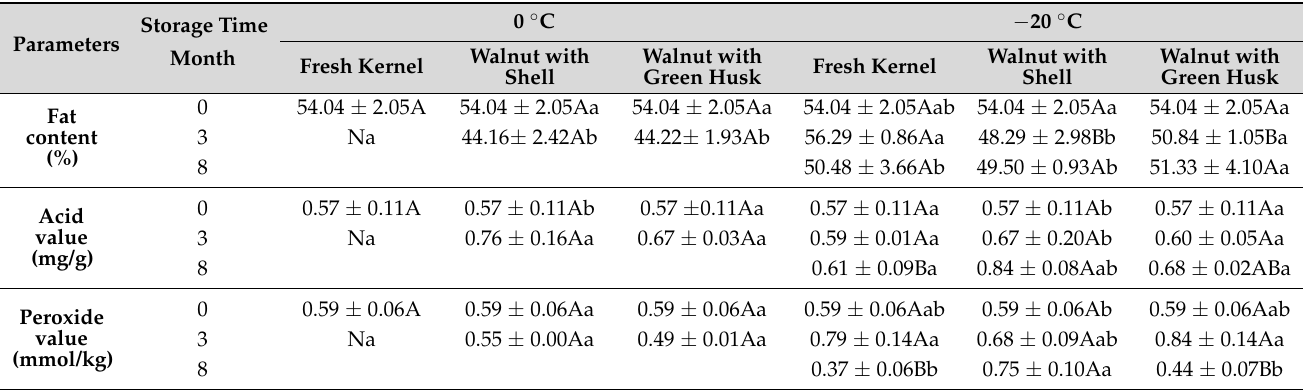
Table 3. Total fat content, acid value and peroxide value of walnut kernels during the storage at 0 ◦ C and − 20 ◦ C. Note: Na means not available. Values with different lowercase letters in the same column ‘a–b’ and uppercase letter ‘A–B’ in the same row are significantly different ( p < 0.05) from each other during